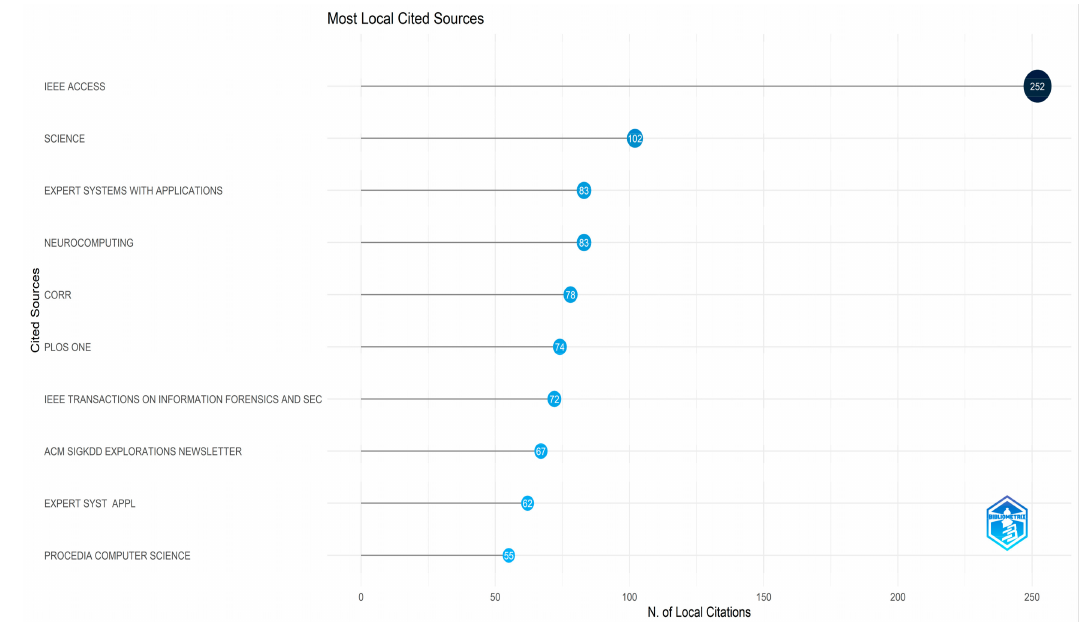
Figure 9. Local cited sources.